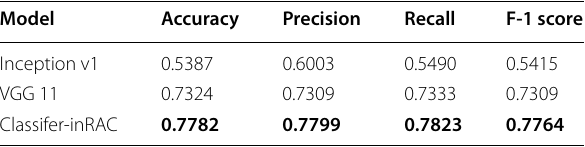
Best value in each column is highlighted in bold